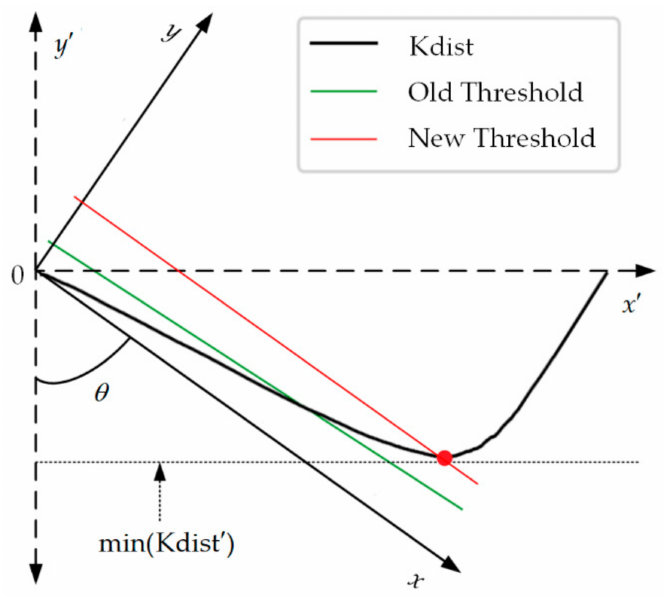
Figure 6. New definition of outlier